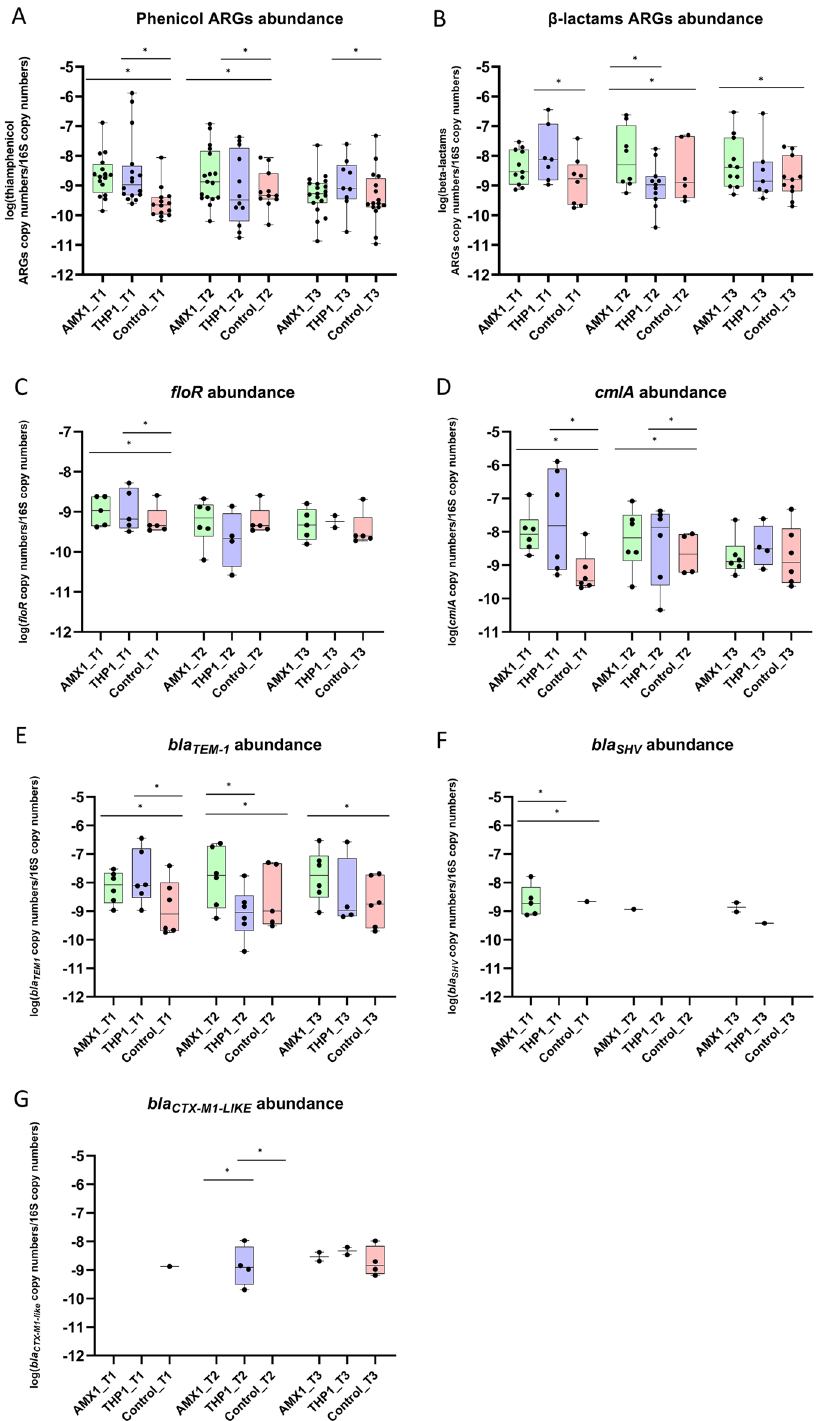
Figure 4. Relative abundance of all genes conferring resistance to β-lactams ( A ) and phenicols ( B ) to 16S rRNA copy number per group per time point after early-age administration of amoxicillin and thiamphenicol. Relative abundance of genes floR ( C ), cmlA ( D ), bla TEM-1 ( E ), bla SHV ( F ), and bla CTX-M1-LIKE ( G ) to 16S rRNA copy number per group per time point. p < 0.05 shown as *. For easiness of representation, only ARGs showing significant differences between groups at the same time point are